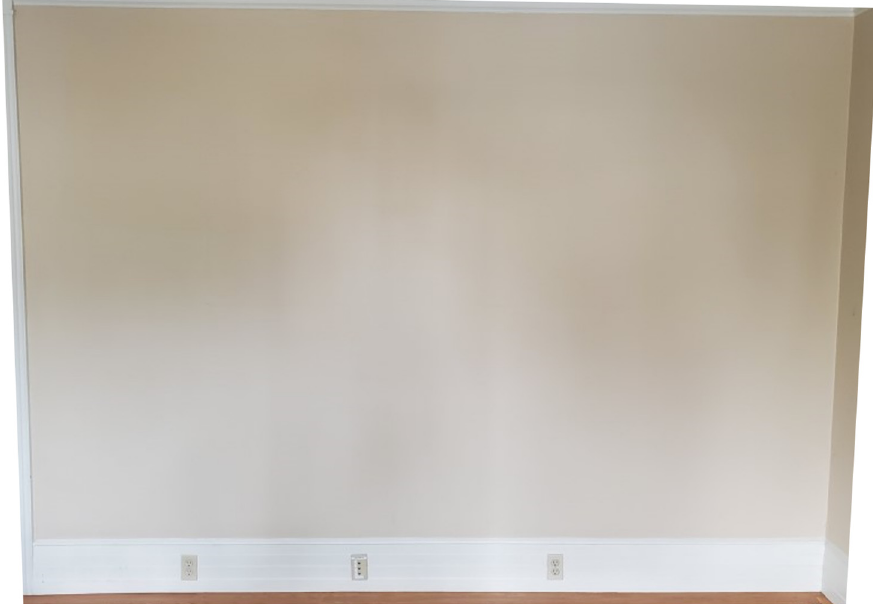
Figure 4. The wall used for investigating Kinect v2 and Azure Kinect sensor accuracy in horizontal and vertical directions.